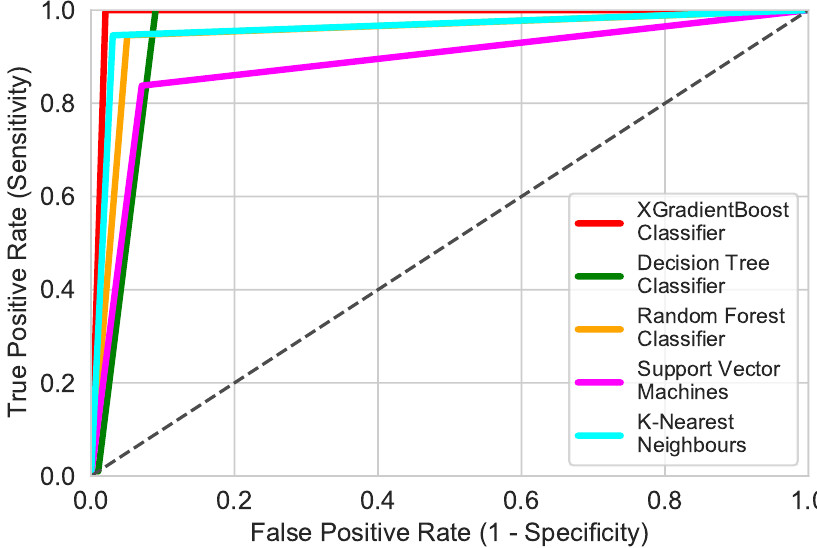
Figure 14. ROC comparison of different